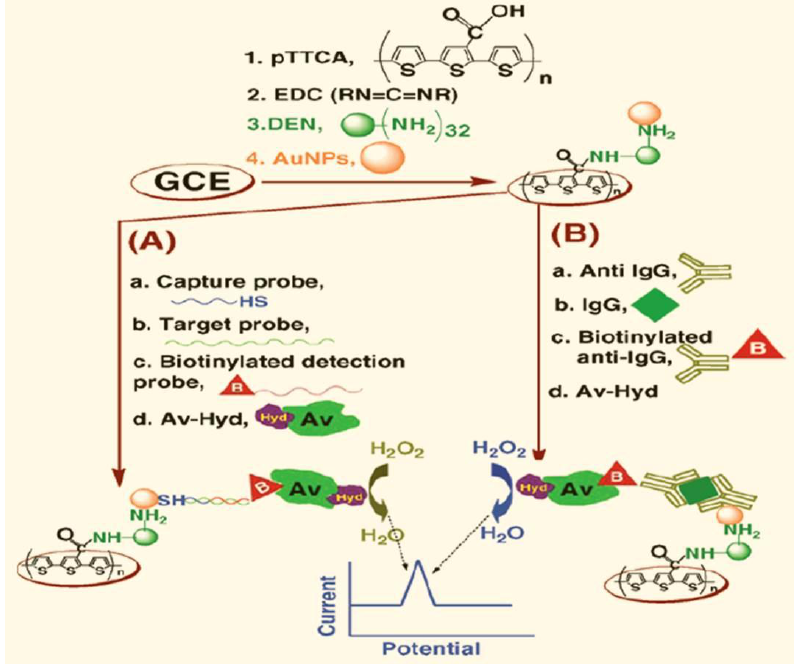
Figure 4. Schematic illustration of the poly-5,2':5',2''-terthiophene-3'-carboxylic acid (pTTCA)/ dendrimer (DEN)/ Au nanoparticles (AuNP)/biomolecule-linked avidin-hydrazine assembly developed for ( A ) DNA and ( B ) protein sensors, based on the electrocatalytic activity of hydrazine. (Reproduced with permission from [154]. Copyright 2014, American Chemical